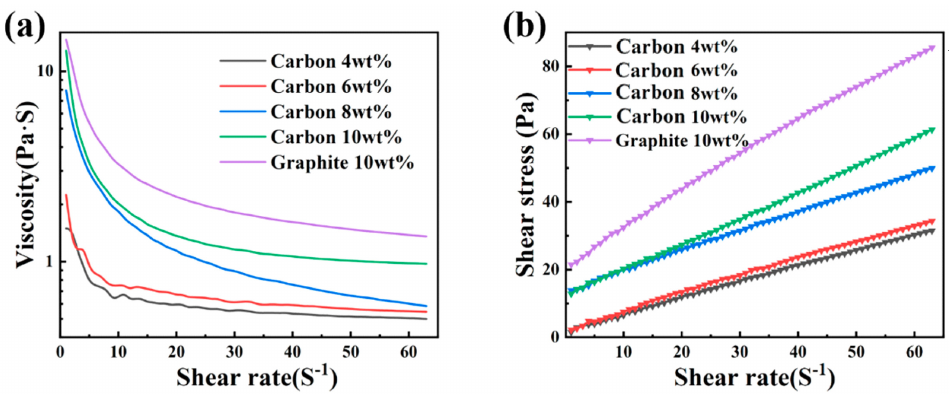
Figure 3. Rheological function of slurries prepared from different carbon sources (a-viscosity curve and b-shear stress curve).